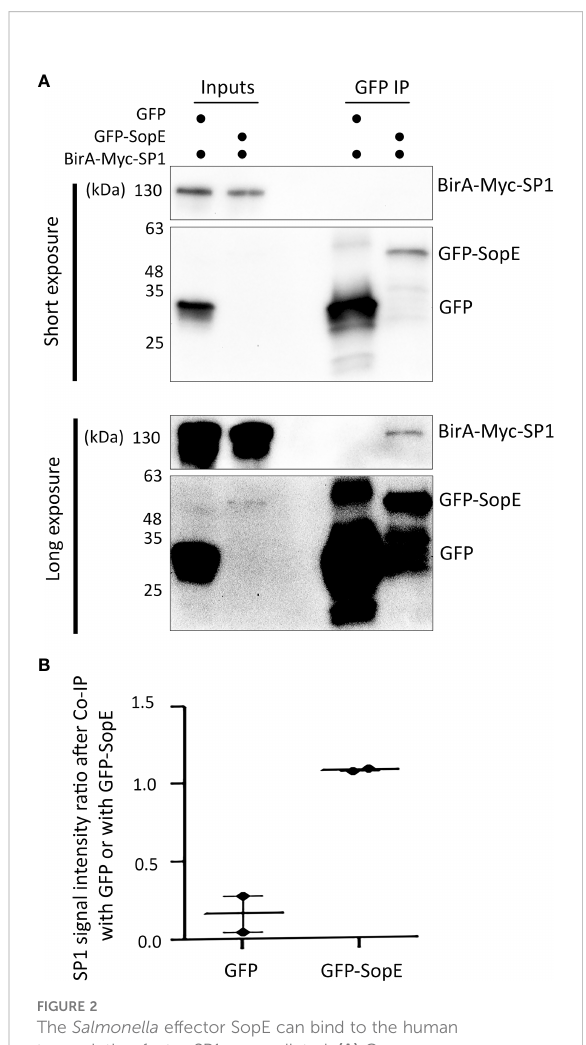
FIGURE 2 The Salmonella effector SopE can bind to the human transcription factor SP1, as predicted. (A) Co- immunoprecipitation of GFP-SopE and BirA-Myc-SP1 ectopically expressed in HEK293 cells. (B) SP1 signal intensity ratio after Co- IP with GFP or with GFP-SopE showing enrichment of SP1 when GFP-SopE is used compared with GFP alone, based on two independent